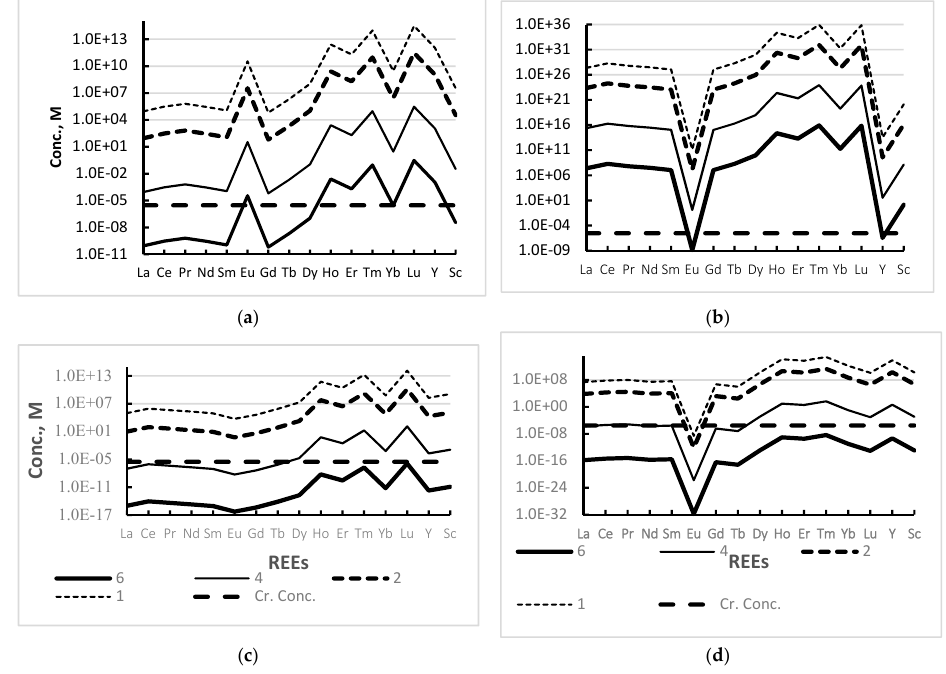
Figure 1. Concentrations of ( a ) Re 3+ , ( b ) ReCl 2+ , ( c ) Re(NO 3 ) 2+ , and ( d ) Re(SO 4 ) 2 − in equilibrium with carbonate precipitate with 10 − 4 M of total concentration of carbonate in solution at pH 6, 4, 2, and 1. Cr.concentration: 1 ppm line as a target concentration.